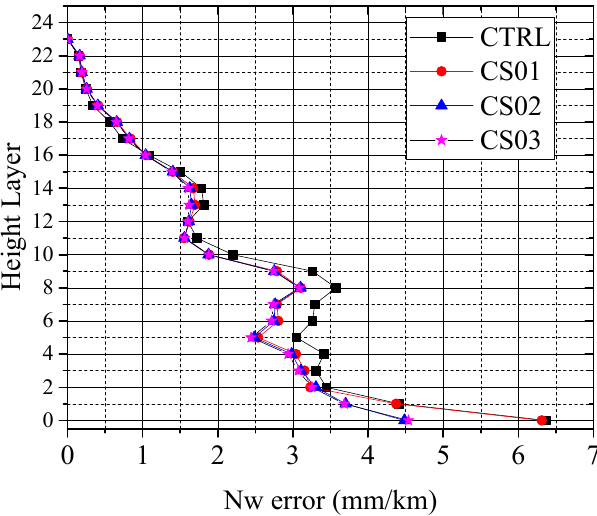
Figure 6. Comparisons of wet refractivity error profiles for CTRL, CS01, CS02, and CS03 for a study of influences of ground observations and ground multi-GNSS observations on tomography.